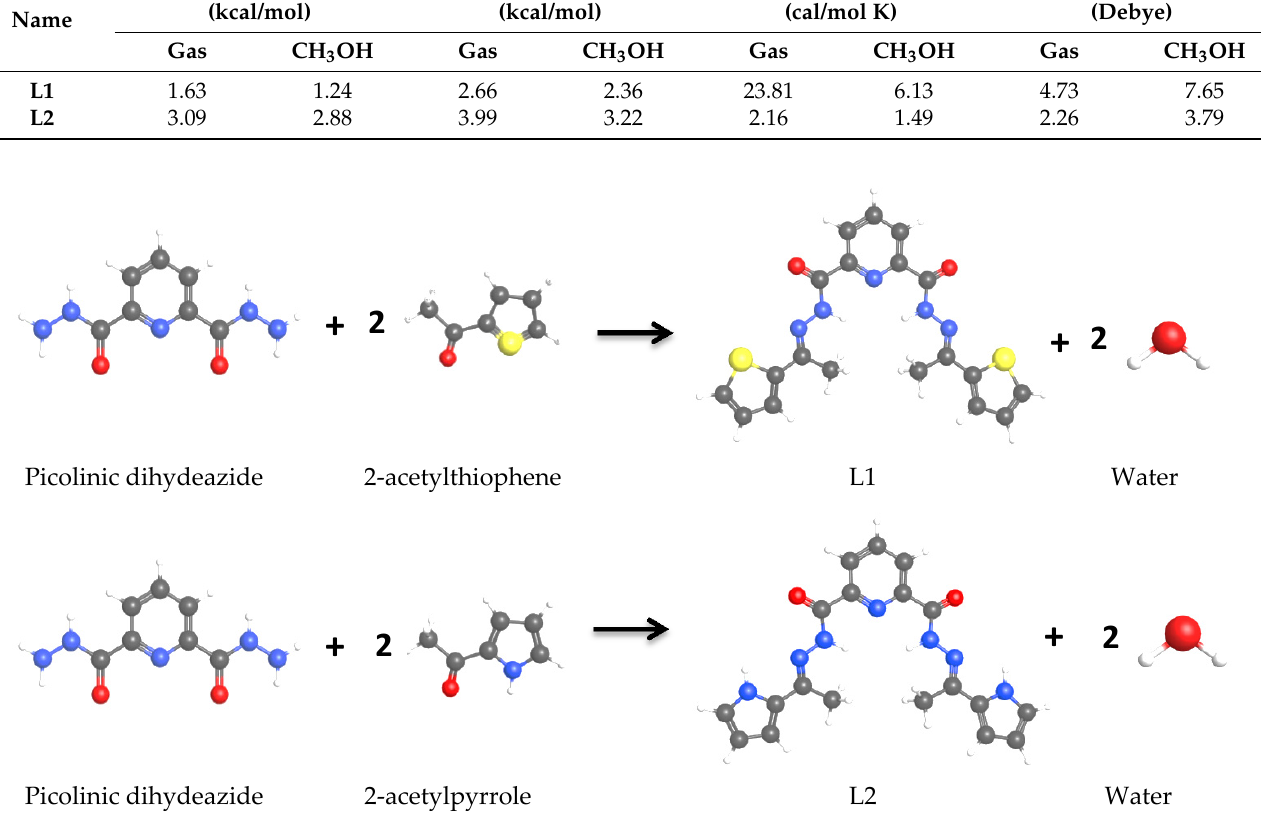
Figure 3. The optimized geometries of the reactants and products involved in chemical reactions calculated at the B3LYP/6-311+ G (d, p) level.